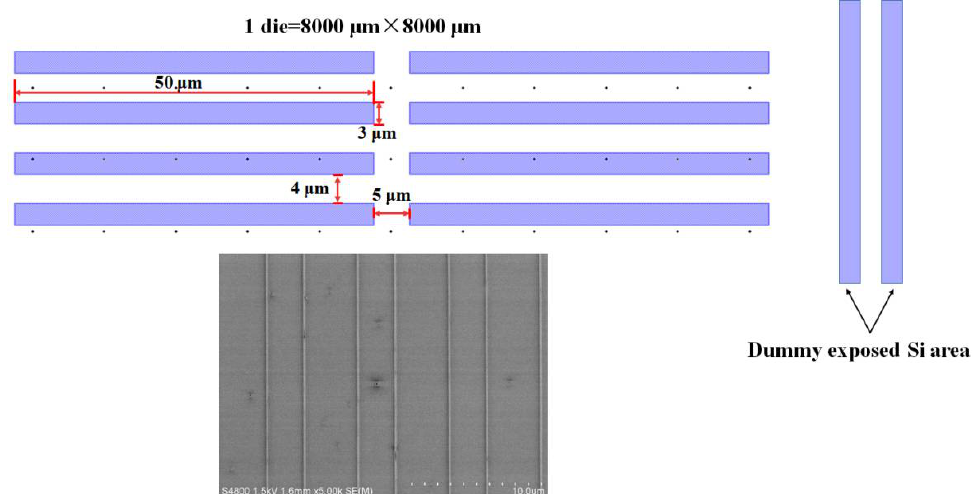
Figure 7 . Layout chip of the fins and plan view of the fins for selective epitaxy. The exposed Si area to the total chip area is almost 1%. The exposed area of the chip has to be compensated by dummy openings at the edge of the wafer.